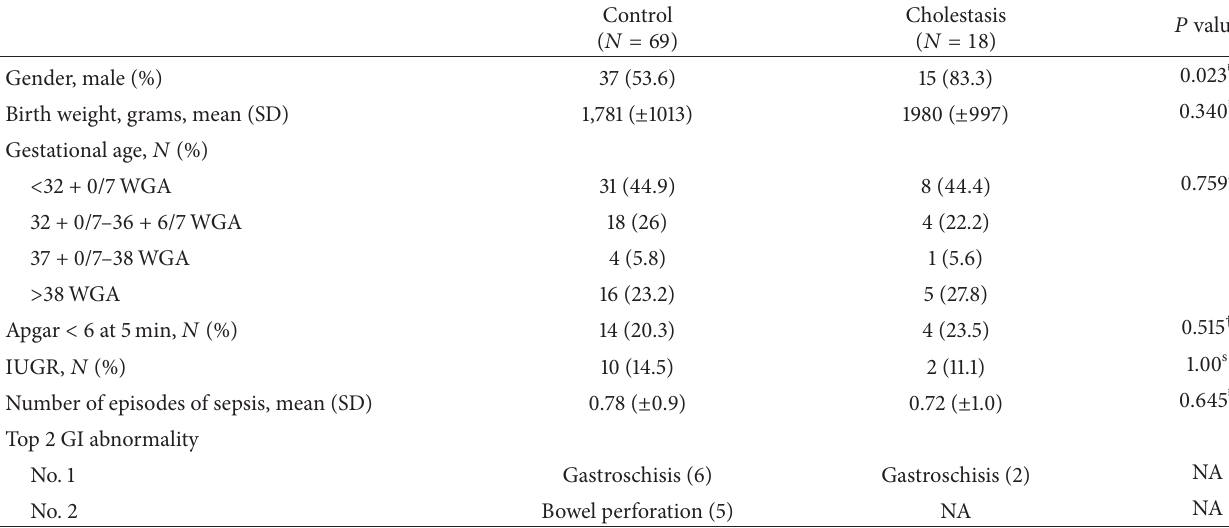
Table 1: Demographics of patients (exposed to PN for at least 2